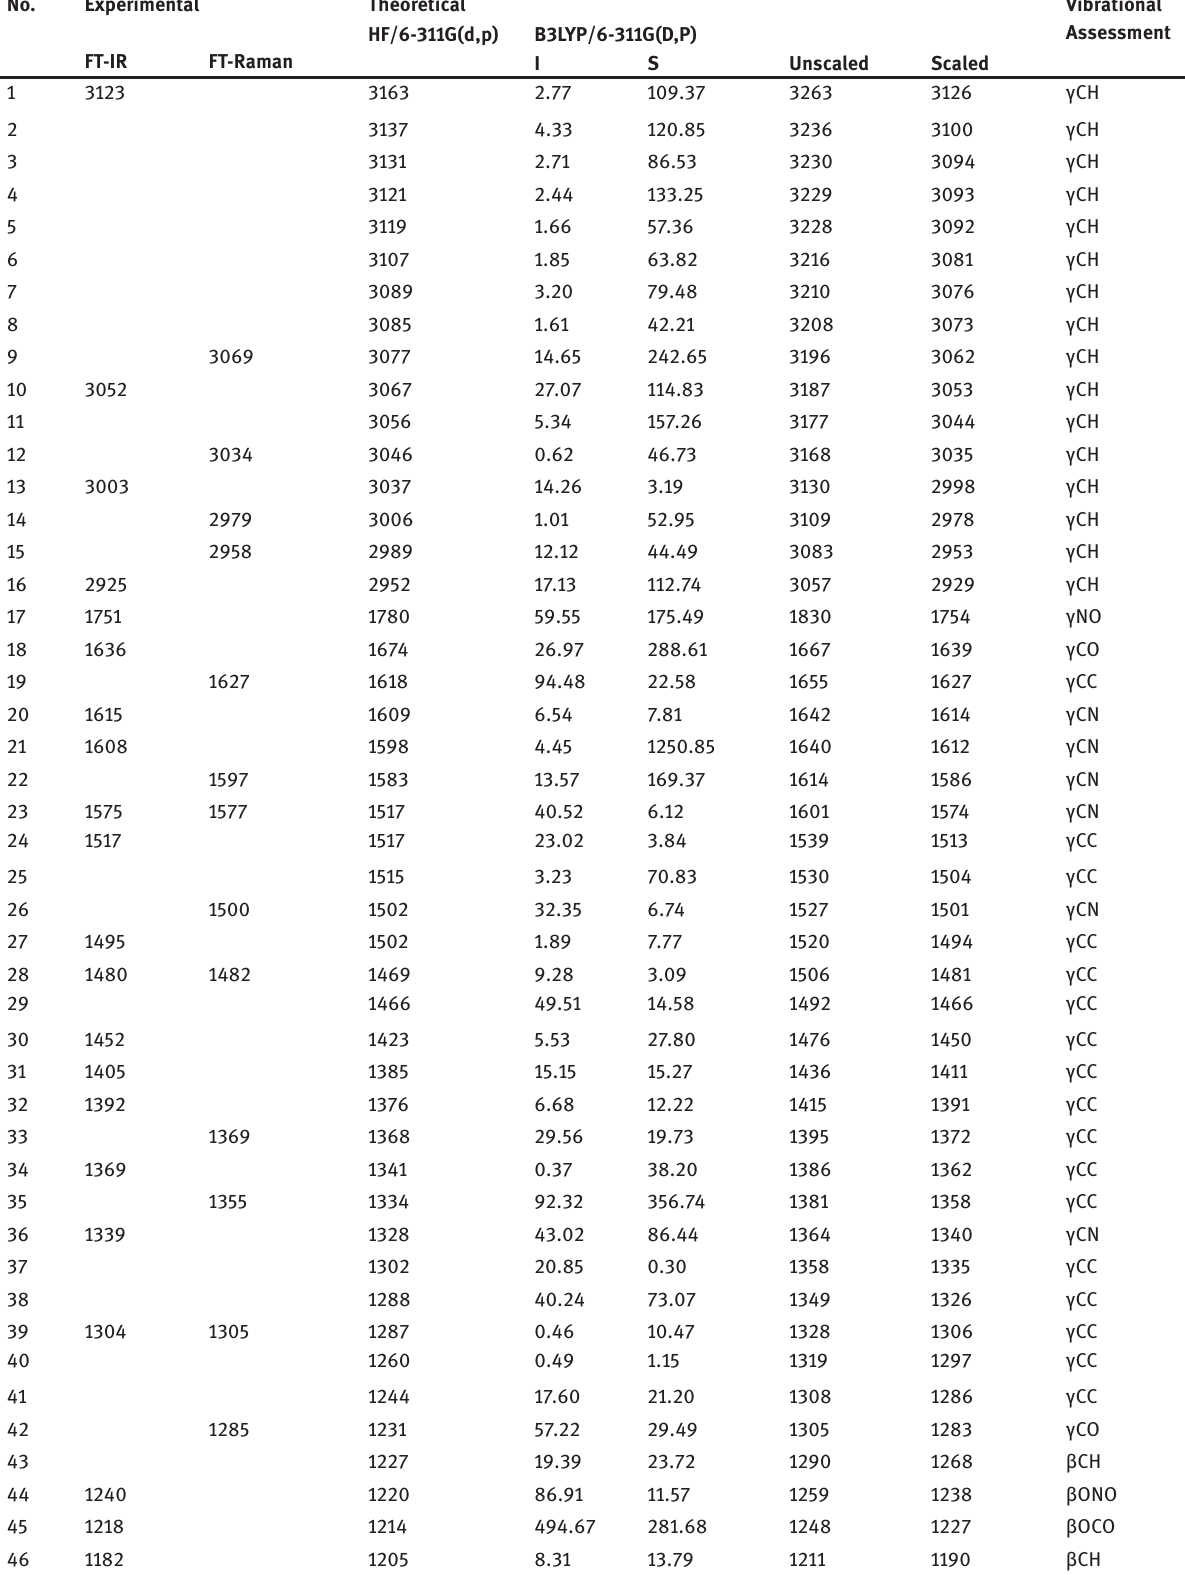
Table 4: Detailed assignments of vibrational bands of the IPAONM molecule along with potential total energy distribution.